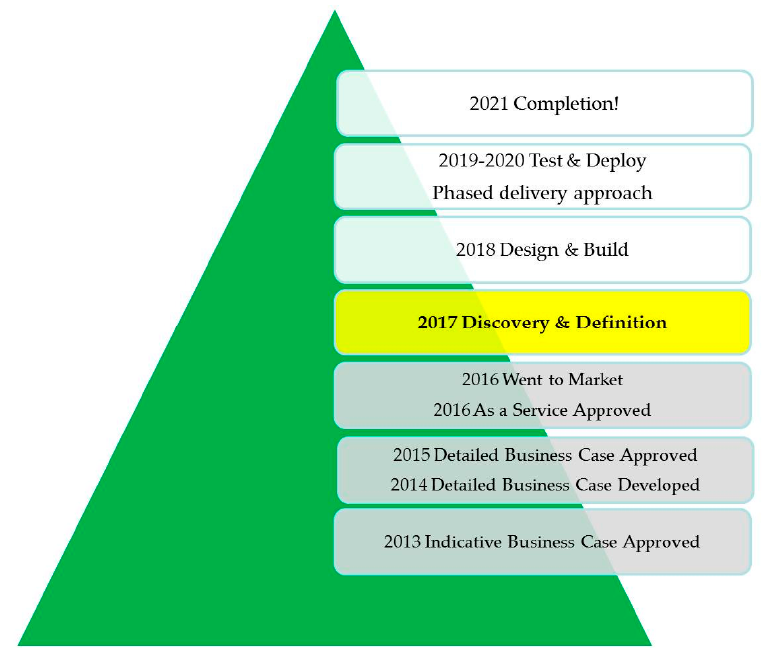
Figure 12. Advanced Survey and Title Services (ASaTS) timeline.